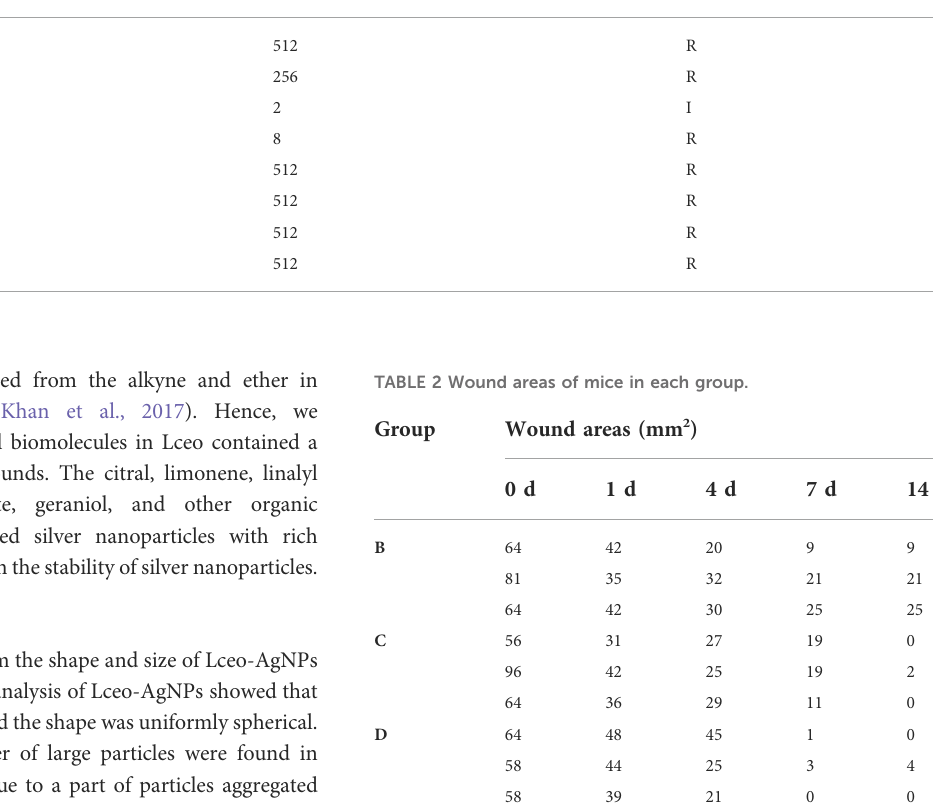
TABLE 1 MIC and antimicrobial susceptibility results of E. coli .